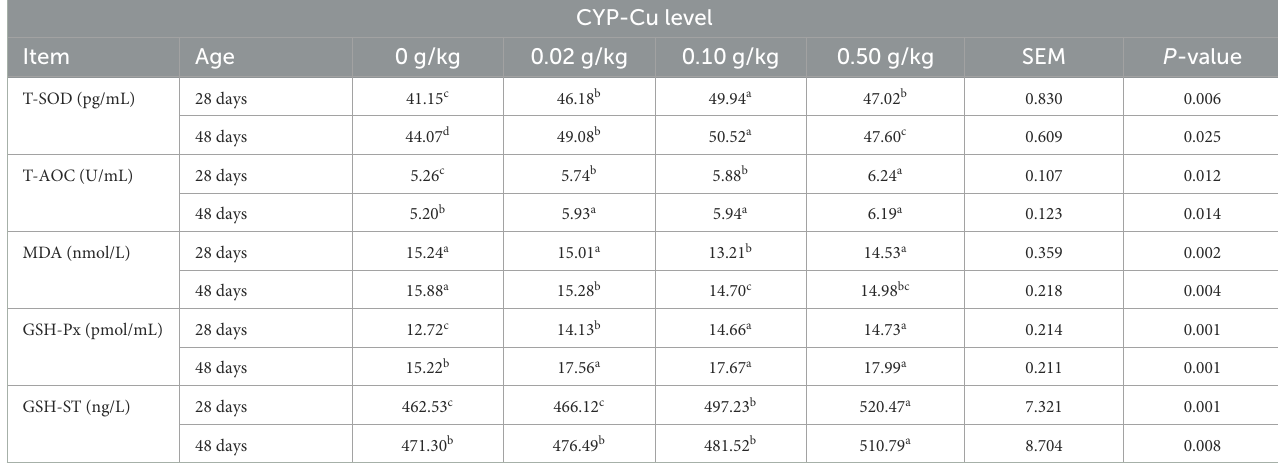
TABLE 7 Effects of dietary CYP-Cu on serum antioxidative parameters in